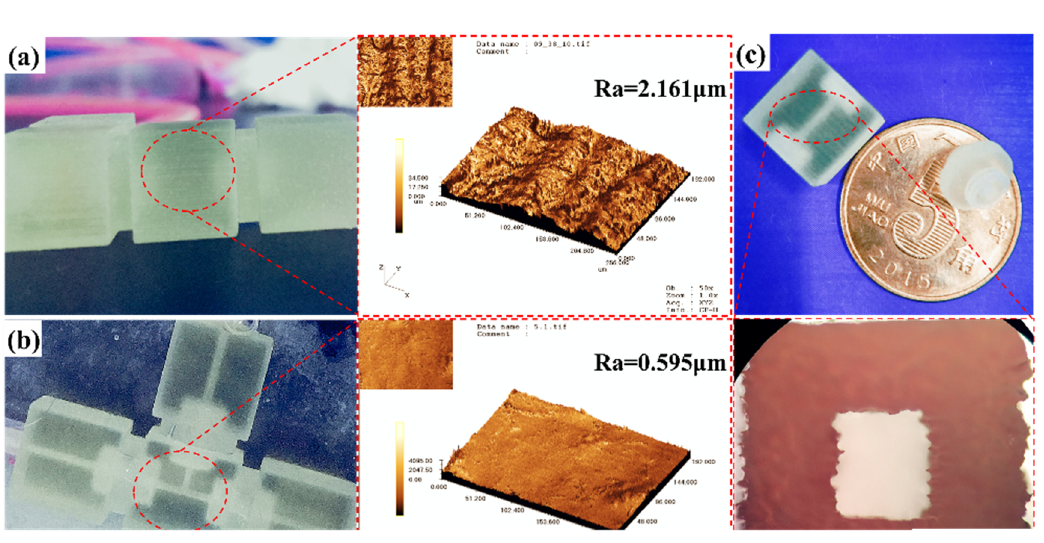
Figure 2. Micrographs of the chip surface quality. ( a ) surface quality and surface roughness before treatment. ( b ) surface quality and surface roughness after polishing and polydimethylsiloxane (PDMS) treatment coating. ( c ) image of 3D printed module components.